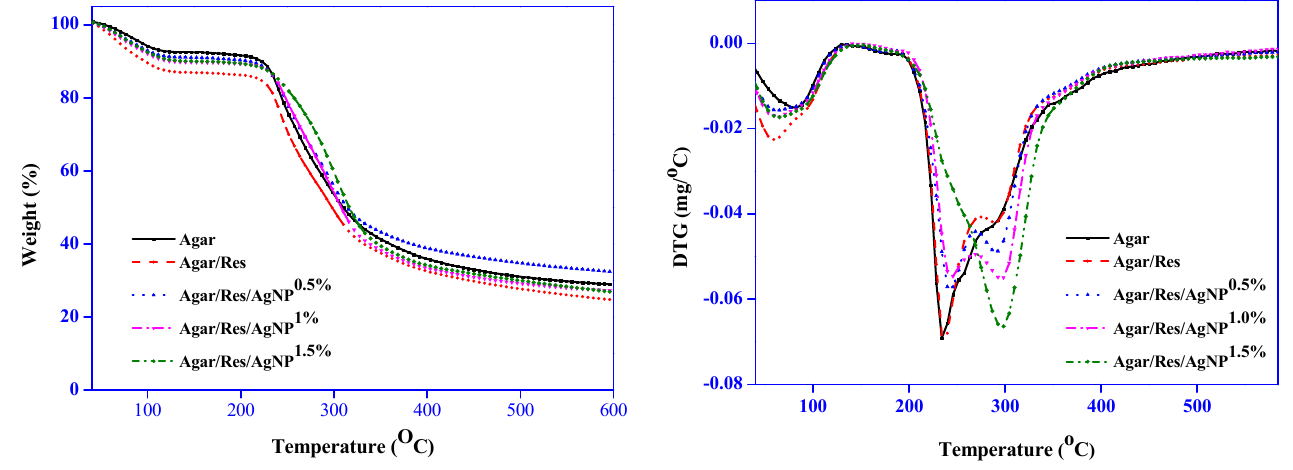
Figure 4. TGA and DTG thermograms of the agar-based composite films.